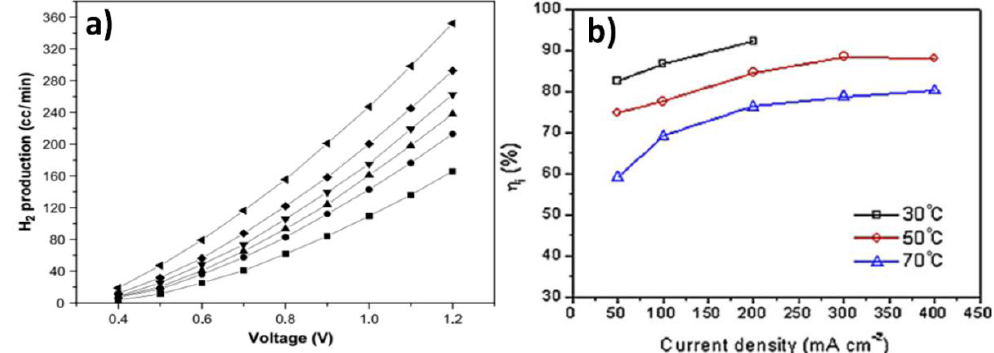
Figure 9. ( a ) E ff ect of operating temperature on methanol electrolysis for pure hydrogen production ( ■ ) 30 °C, (●) 40 °C, ( ▴ ) 50 °C, ( ▾ ) 60 °C, ( ♦ ) 70 °C and ( ◀ ) 80 °C. Adapted with permission from [6], copyright 2008. ( b ) E ff ect of operating temperature on corresponding current e ffi ciency. Adapted